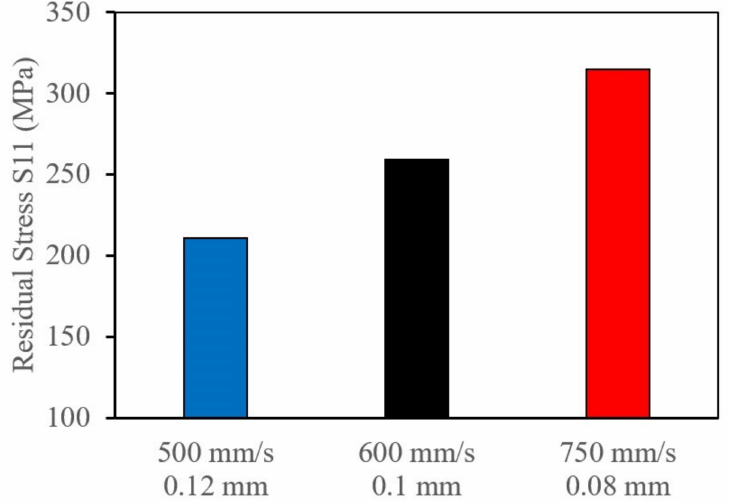
Figure 34. Surface RS at a constant energy density of 3.67 J/mm 2 .